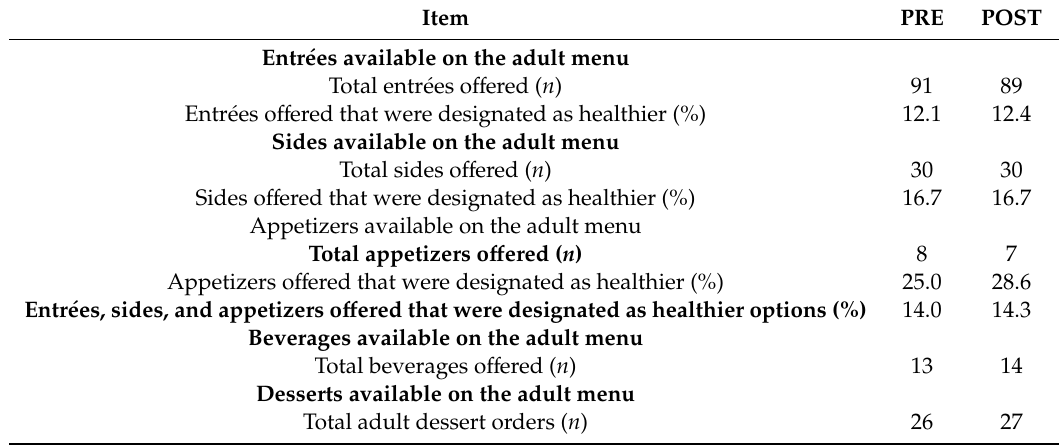
Table 2. Menu items o ff ered on the adult menu before (PRE) and after (POST) the implementation of a healthier children’s menu by meal